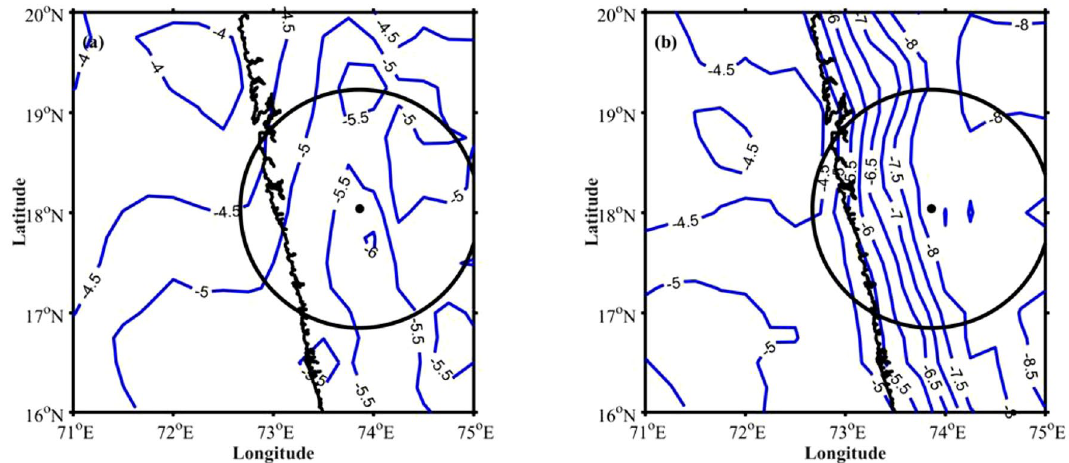
Figure 8. Equivalent potential temperature difference (K) between 500 and 850 hPa levels during ( a ) 0000– 0300 LT and ( b ) 1200–1500